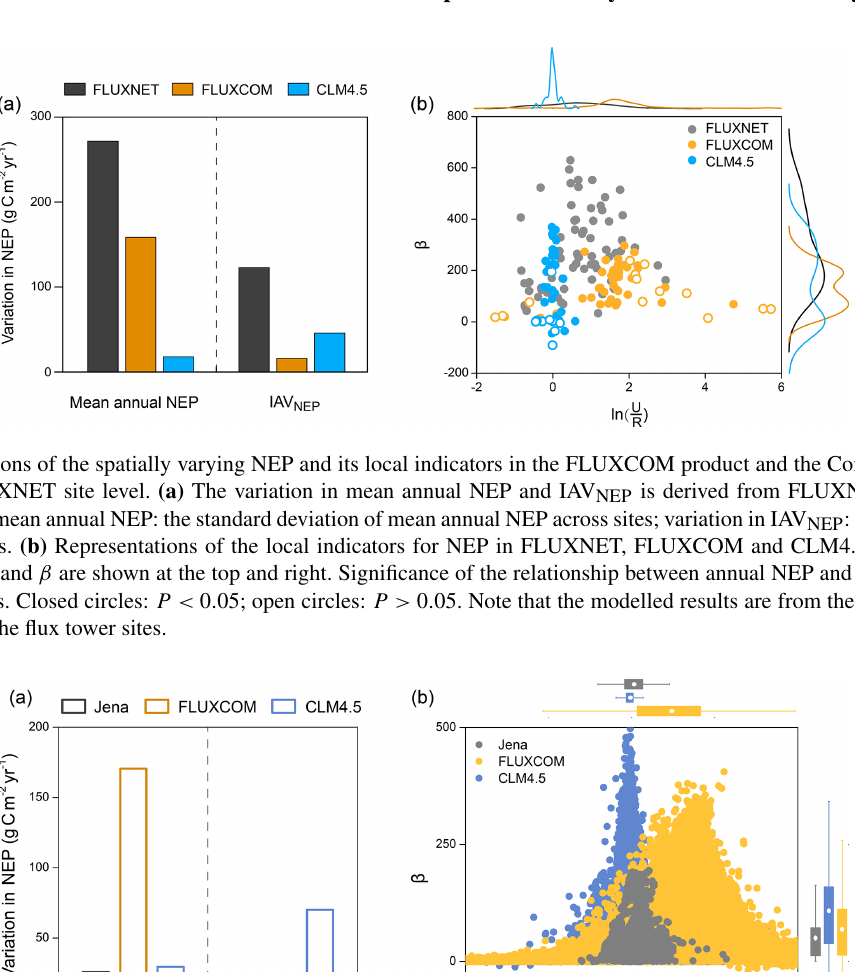
Figure 6. Representations of the spatially varying NEP and its local indicators in the FLUXCOM product and the Community Land Model (CLM4.5) at the global scale. (a) The variation in mean annual NEP and IAV NEP is derived from Jena CarboScope inversion, FLUXCOM and CLM4.5. Variation in mean annual NEP: the spatial variation in mean annual NEP; variation in IAV NEP : the spatial variation in standard deviation in IAV NEP . (b) Representations of the local indicators for NEP in Jena CarboScope inversion, FLUXCOM and